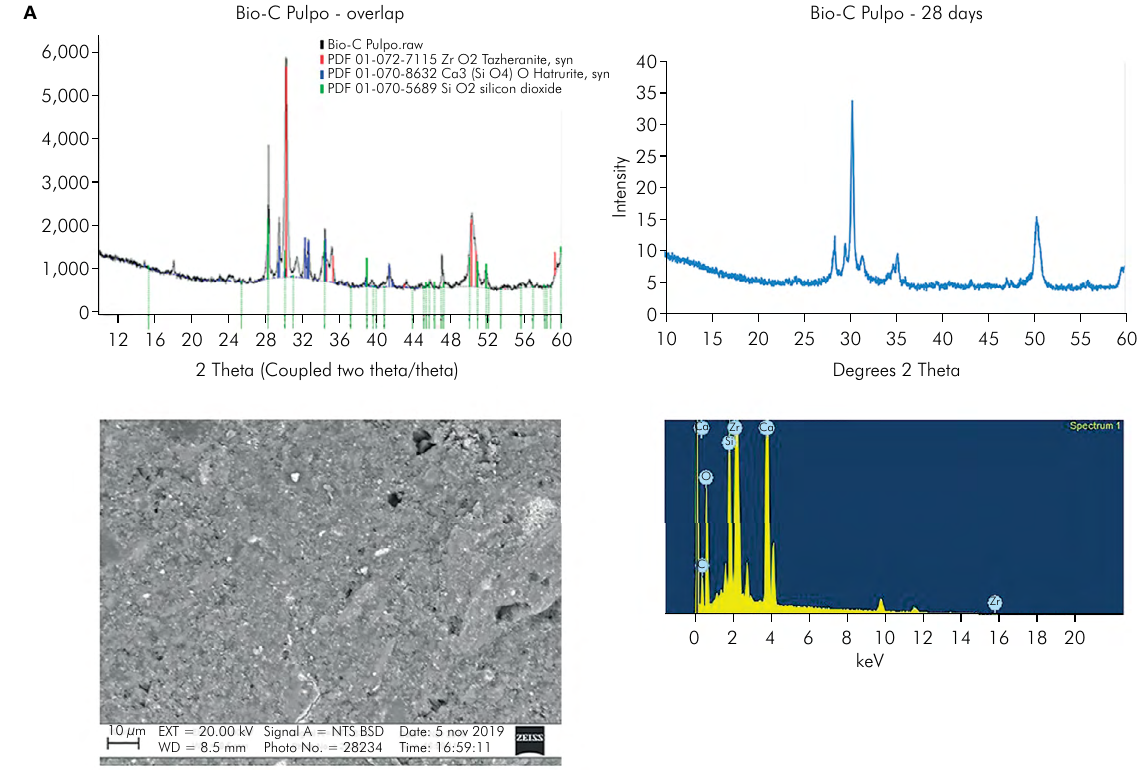
Figure 2. (a, b, c) Representation of X-ray diffraction plots of hydrated cement and overlapped-diffraction of the tested hydraulic calcium silicate-based materials. XRD analysis detected calcium hydroxide (portlandite) deposition for MTA Repair HP and MTA Angelus hydrated samples after 28-day immersion in Hank’s Balanced Salt Solution (HBSS). Conversely, Bio-C Pulpo did not present the portlandite phase, indicating the absence of calcium hydroxide deposition after hydration and HBSS immersion. SEM micrographs and EDS plots of hydrated cement revealed particles of cement interposed with small particles of radiopacifier, and with respective element peaks.